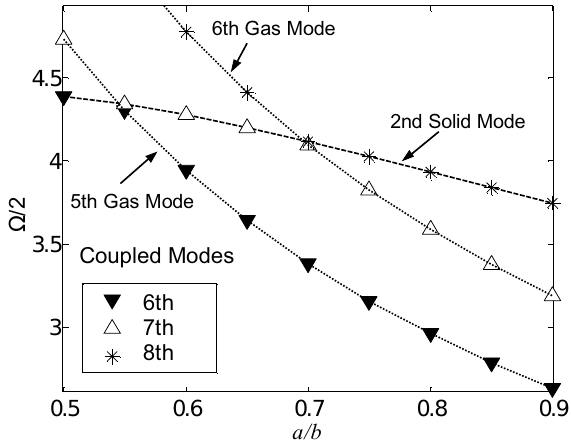
Fig. 3. Non-dimensional resonance frequency, vs geometry for circumferential wave number one, of the coupled air filled